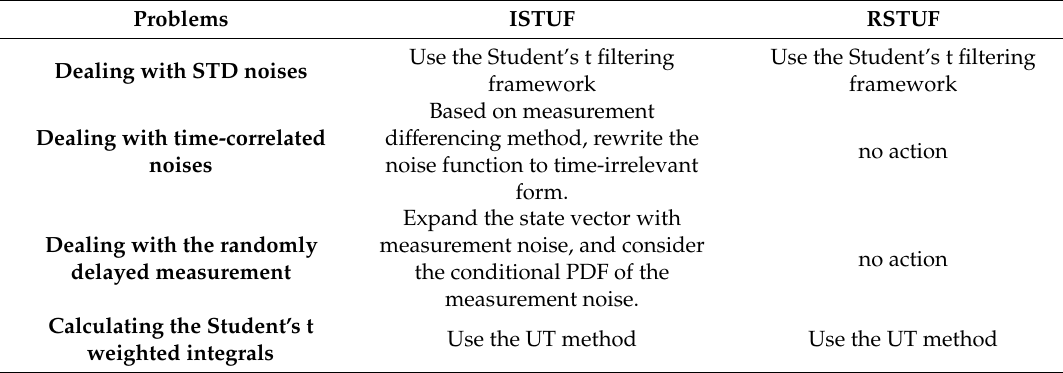
Table 1. The di ff erence between improved Student’s t based unscented filter (ISTUF)and